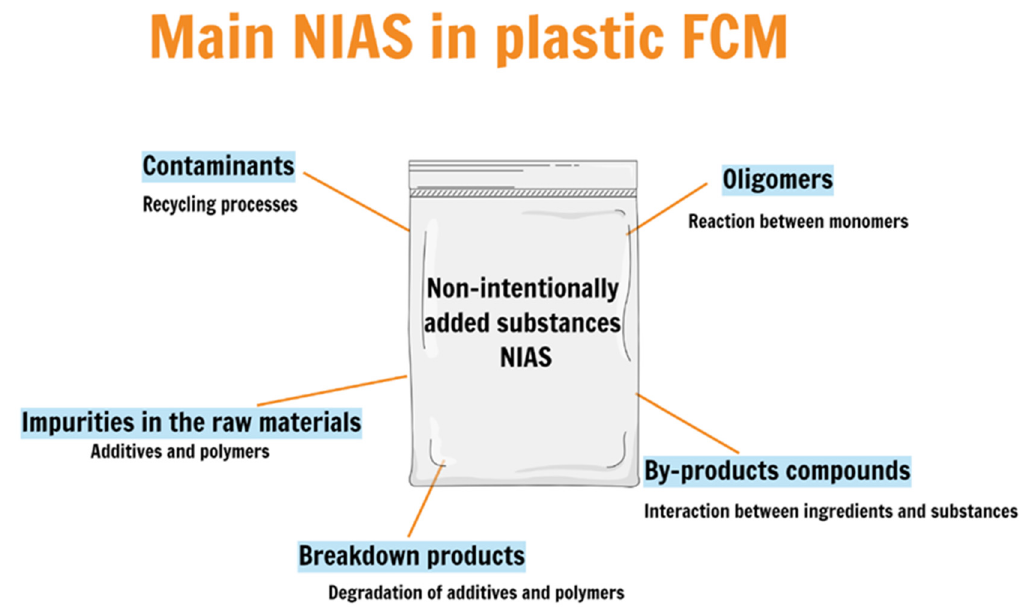
Figure 3. Mainly examples of NIAS formed during food plastic contact materials manufacturing, during the foodstuff’s shelf life, or during some processing (i.e., heating or irradiation).